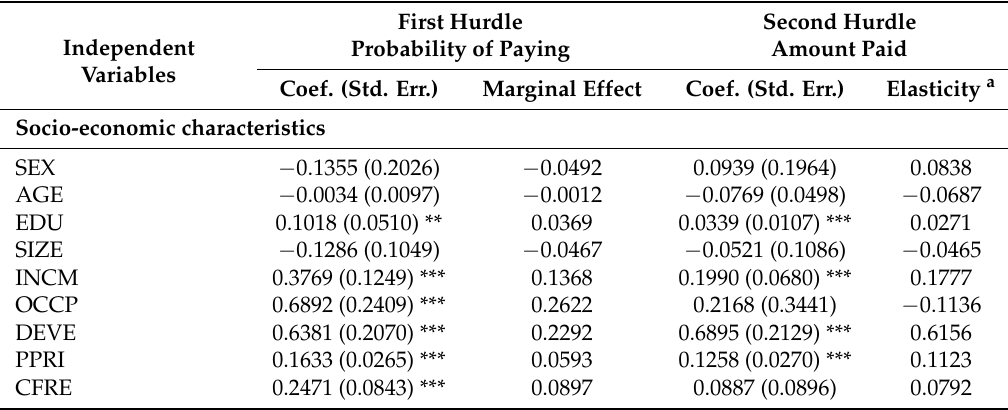
Table 3. Estimation results of the double-hurdle